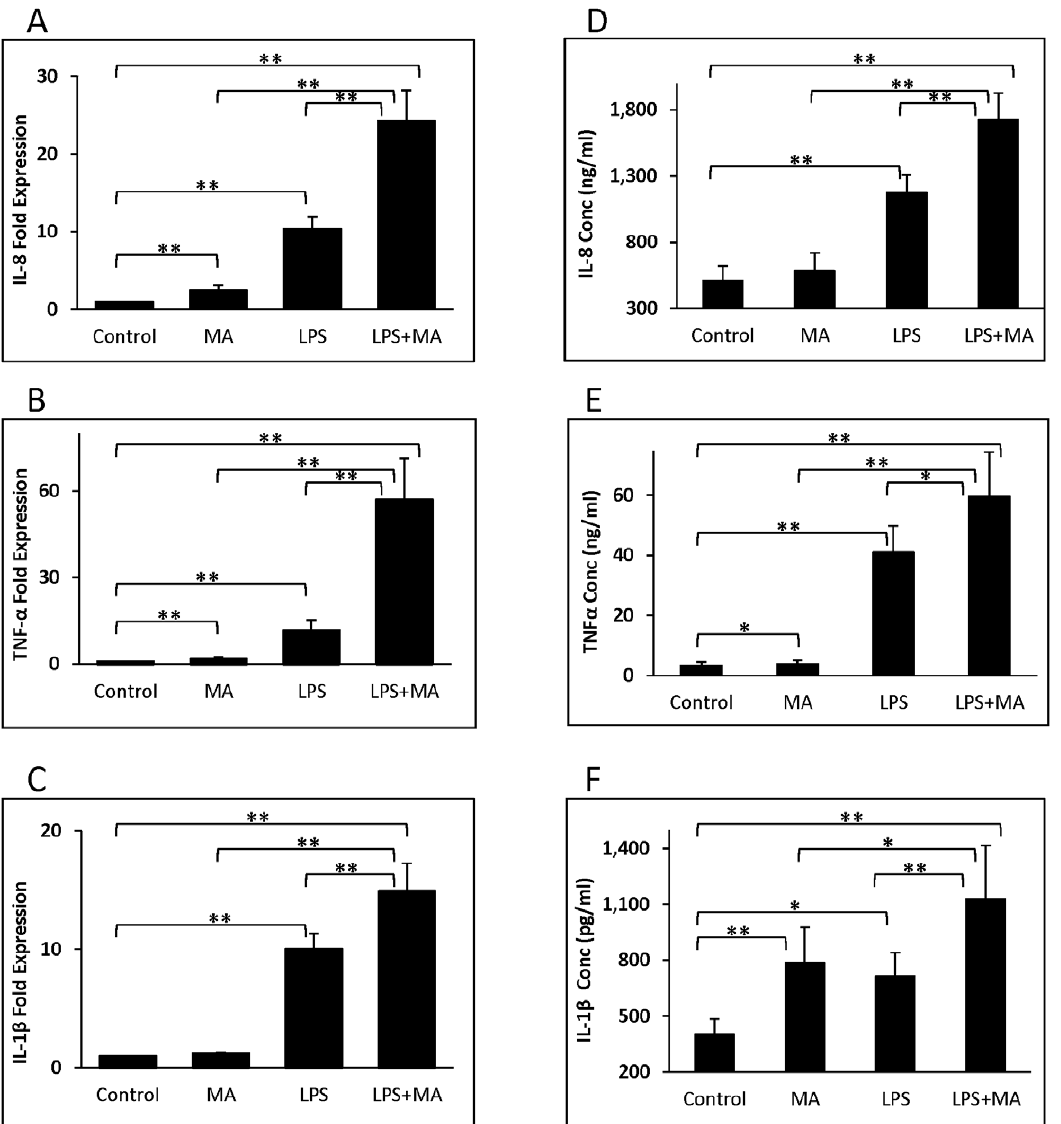
Figure 1. Treatment of U937 macrophages with MA or/and LPS induced an increase in IL-8, TNF- a , and IL-1 b . Cells were differentiated into macrophages by treatment with 100 nM PMA for 48 h. Cells were treated with MA at 0, 24 and 48 h and then stimulated with 100 ng/ml LPS for 3 h, after which they were harvested. RNA was isolated and analyzed with real-time RT-PCR (A–C). In a separate experiment, cells were treated with MA at 0, 24 and 48 h then stimulated with 100 ng/ml LPS for 24 h and the cytokines in supernatants were measured using Bio-Plex (D–F). The error bars show standard error of three independent experiments. *: p , 0.05; **: p , 0.01.